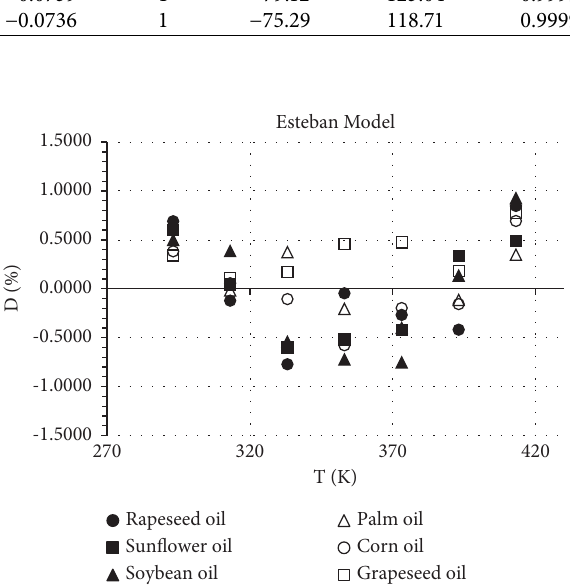
Figure 4: Relative deviations (% Δ ) between the surface tension of the Esteban model by equation (3) and the experimental values reported by Esteban et al.